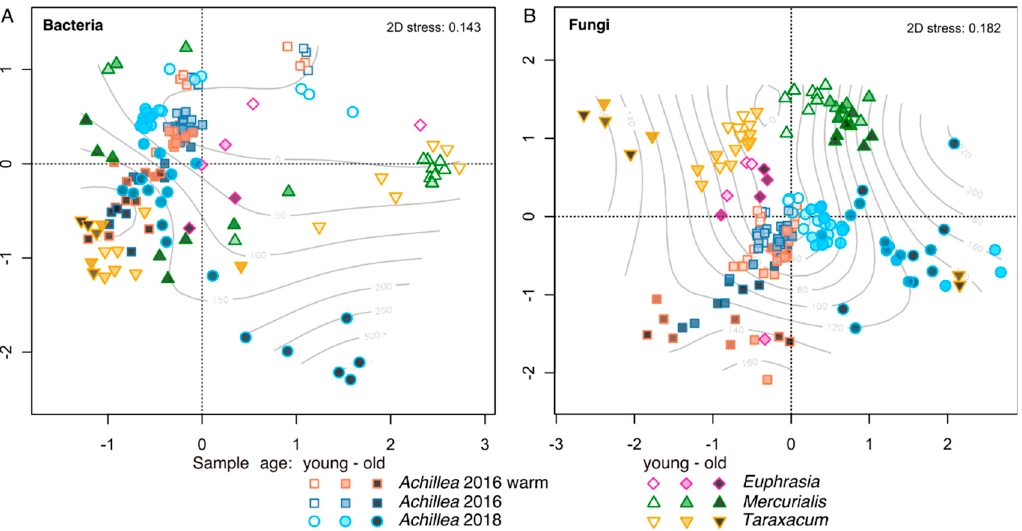
Figure 6. Non-metric multidimensional scaling (NMDS) analysis of bacterial ( A ) and fungal ( B ) com- munities during the fermentation of Achillea , Mercurialis , Taraxacum , and Euphrasia , according to the GHP. Achillea 2016 was also fermented at permanently warm conditions during the initial 7 days. Isolines indicate age of the preparation in